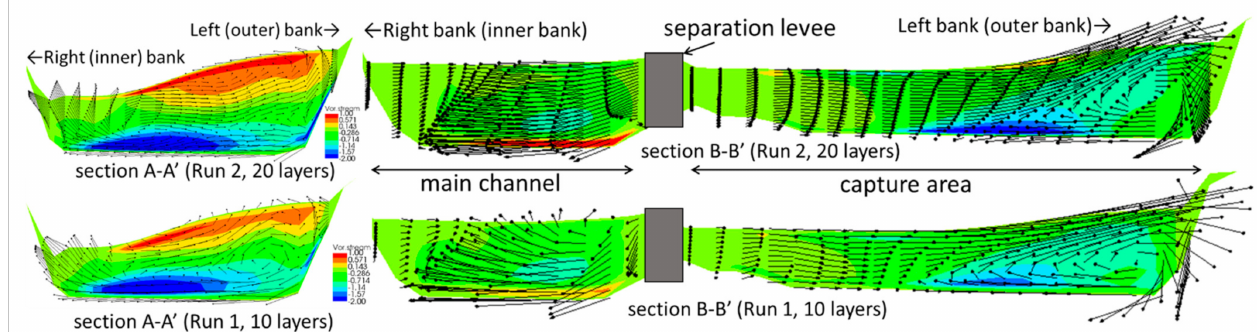
Figure 9. Cross-sectional velocity vectors and color contour of streamwise vorticity along A-A’ and B-B’ sections (upper: vertical grid division of 20 layers (Run 2), lower: vertical grid division of 10 layers (Run 1)).